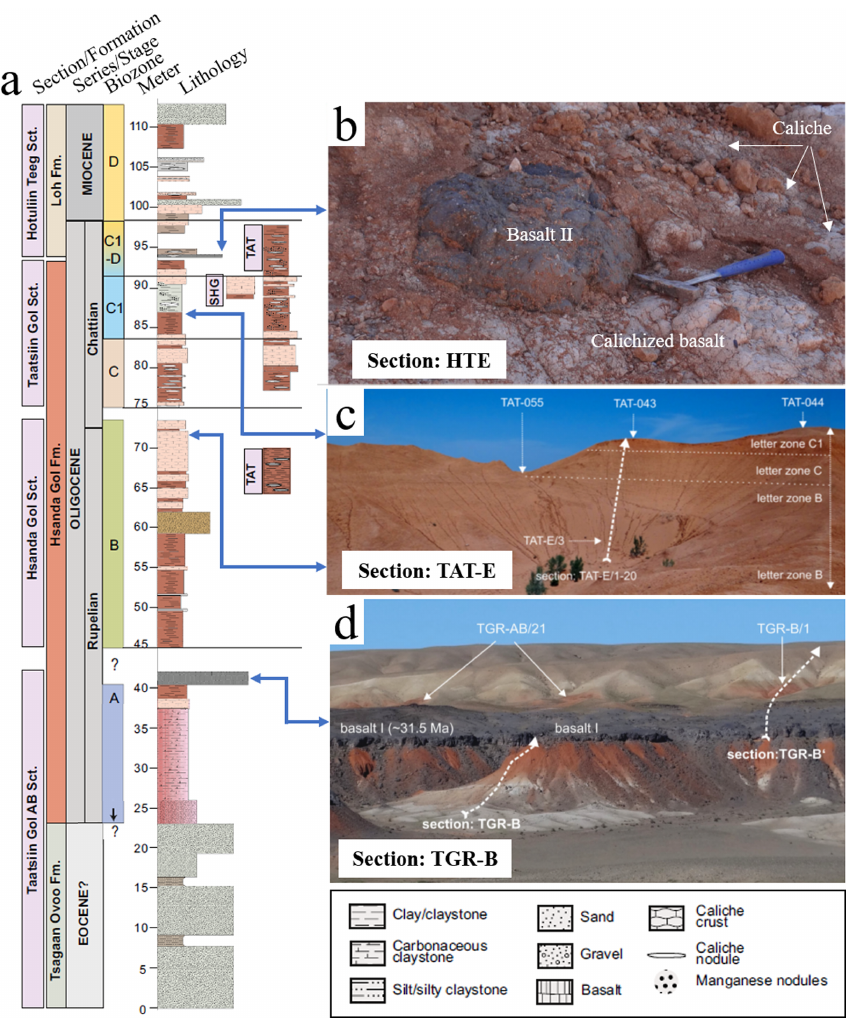
Figure 2. (a) Integrated lithostratigraphic profile of the investigated sedimentary succession from the Taatsiin Gol region, Valley of Lakes (modified after Richoz et al., 2017), with biozonation (modified after Harzhauser et al., 2017). (b–d) Field impressions of the sections: Hotuliin Teeg (HTE) with the calichized basalt II group, Tatal Gol (TAT-E) sediments and the Taatsiin Gol right (TGR-B) section with the basalt I group (modified after Daxner-Höck et al.,